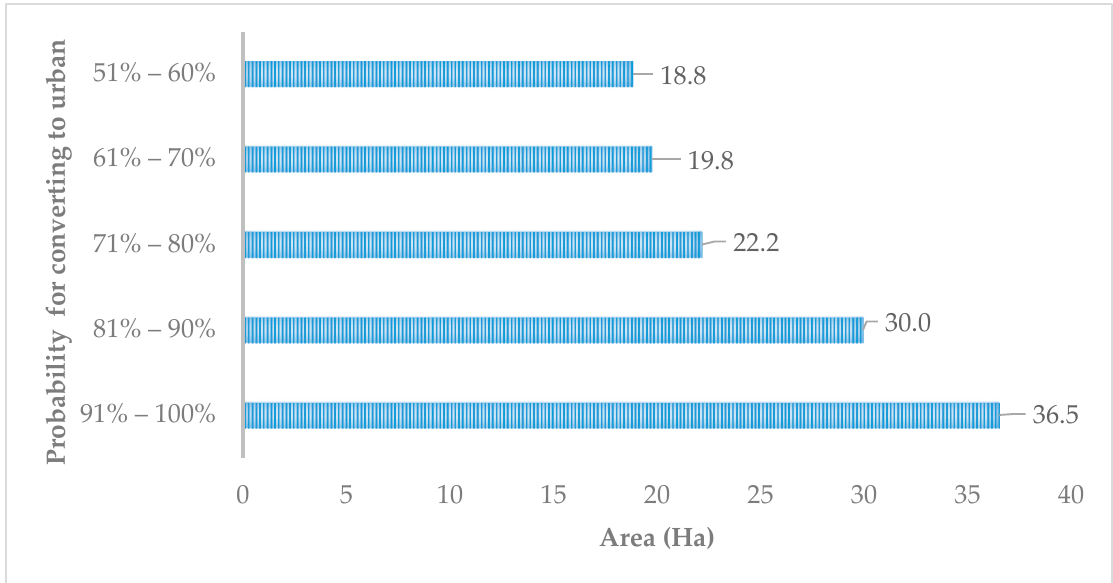
Figure 7. Potential area requirements for urban growth in Monastir by 2030, according to the BaU prediction.